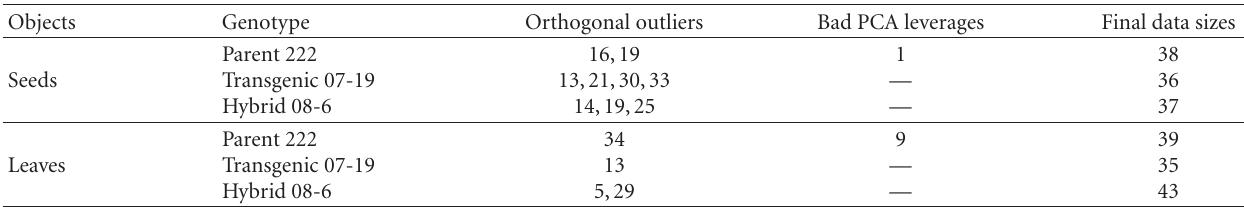
Figure 2: Some of the NIR spectra of cotton leaves preprocessed by (a) smoothing, (b) second-order derivative, and (c) SNV. The genotypes were (1) parent 222, (2) transgenic 07-19, and (3) hybrid 08-6. Table 2: Results of outlier diagnosis.